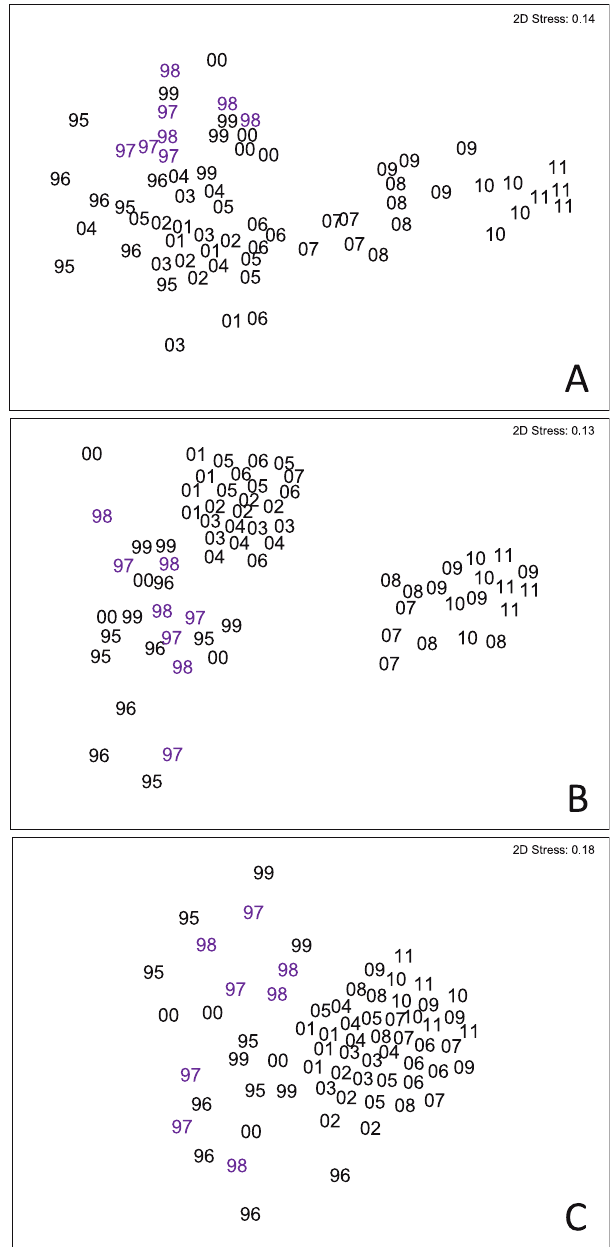
Figure 5. Non-metric multidimensional scaling ordination of sponge assemblage data from the four assessed shallow-bank reefs from northern Bahia (Praia do Forte, Itacimirim, Guar- ajuba and Abai) throughout the sampling period, 1995–2011. Based on [ln (x + 1)]) transformed species densities and Bray Curtis similarities. (A): ERT; (B): CRW; (C): SBR. Codes refer to the year of sampling (i.e. 00=2000).